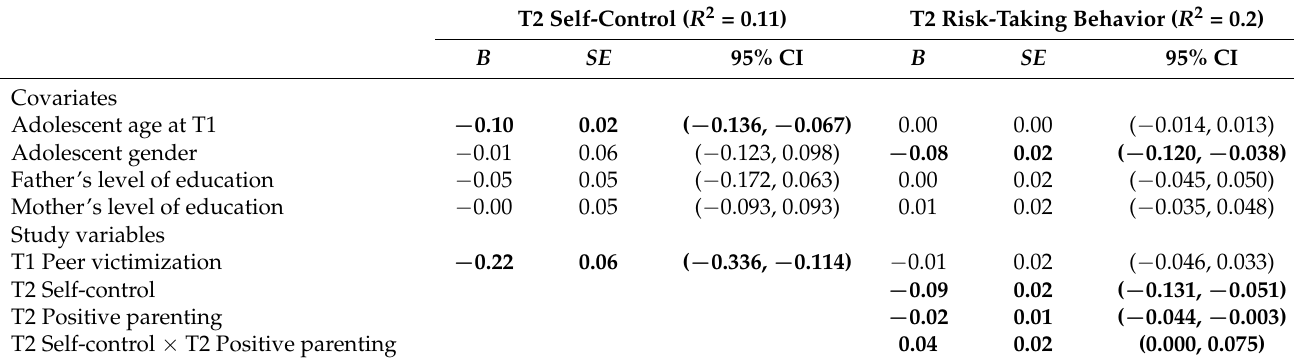
Table 3. Summary of the moderated mediation model. T2 Self-Control ( R 2 = 0.11)